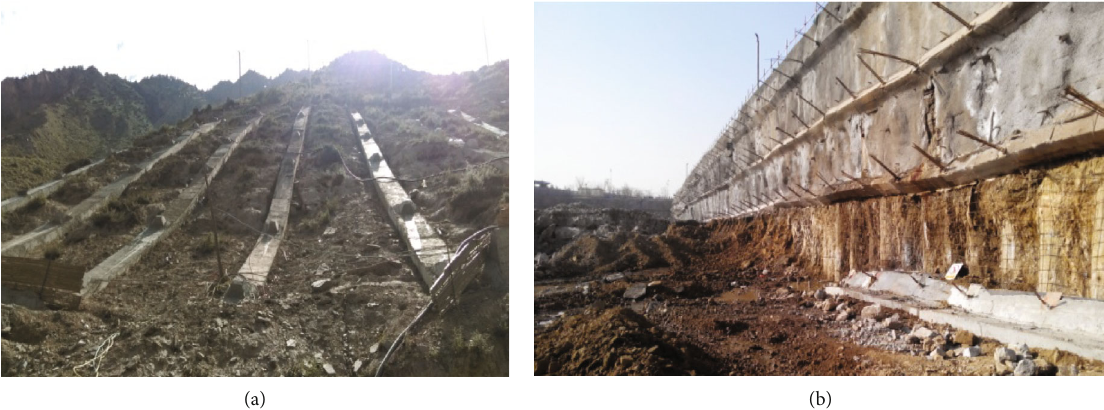
Figure 1: Application of prestressed anchor cable: (a) used in a high slope and (b) used in a deep foundation pit.